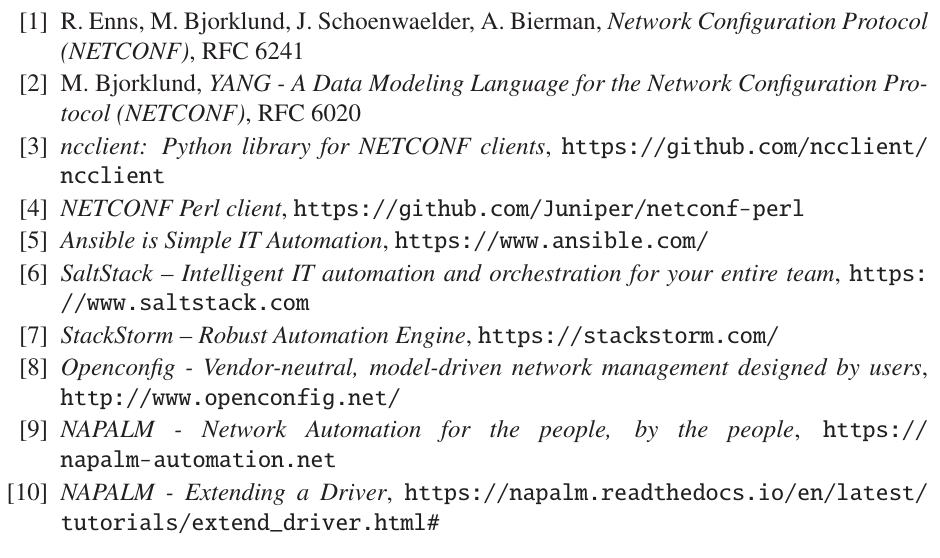
Figure 4: Evolved network configuration